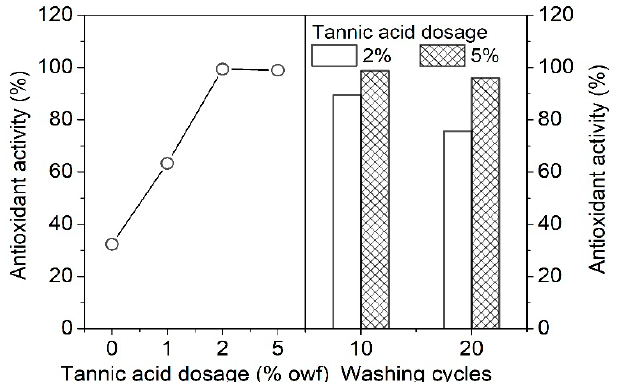
Figure 8. Antioxidant activity of the silk fabric treated with different concentrations of tannic acid, and the washing durability of the silk fabrics treated with 2 and 5% tannic acid.